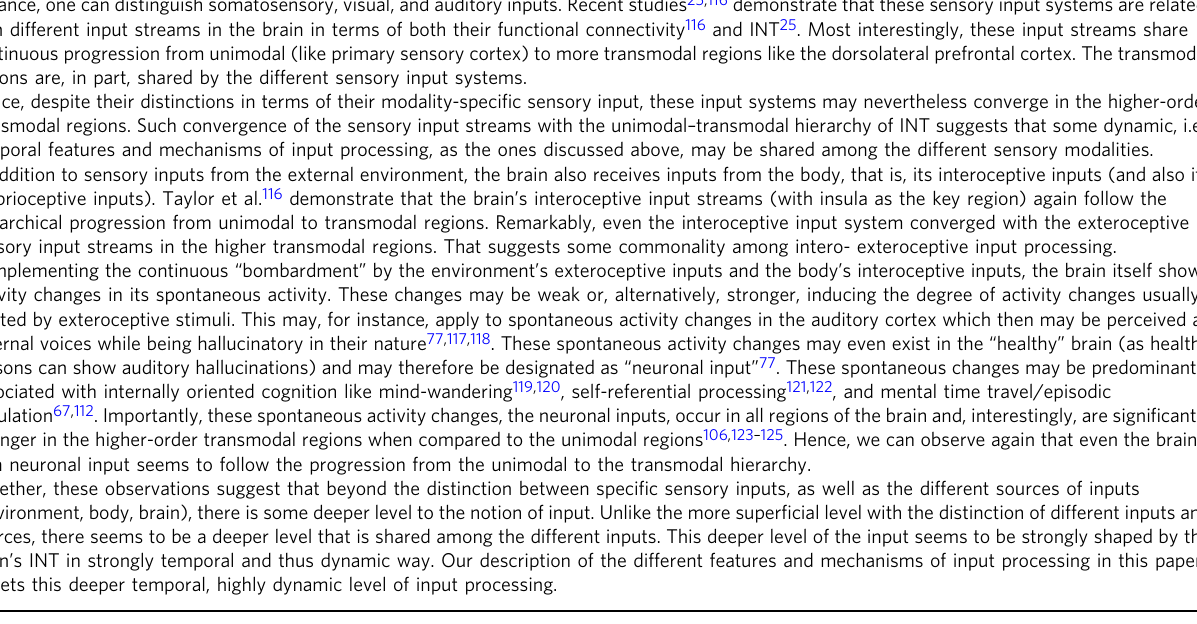
Box 1 | Inputs: deeper dynamic levels of input